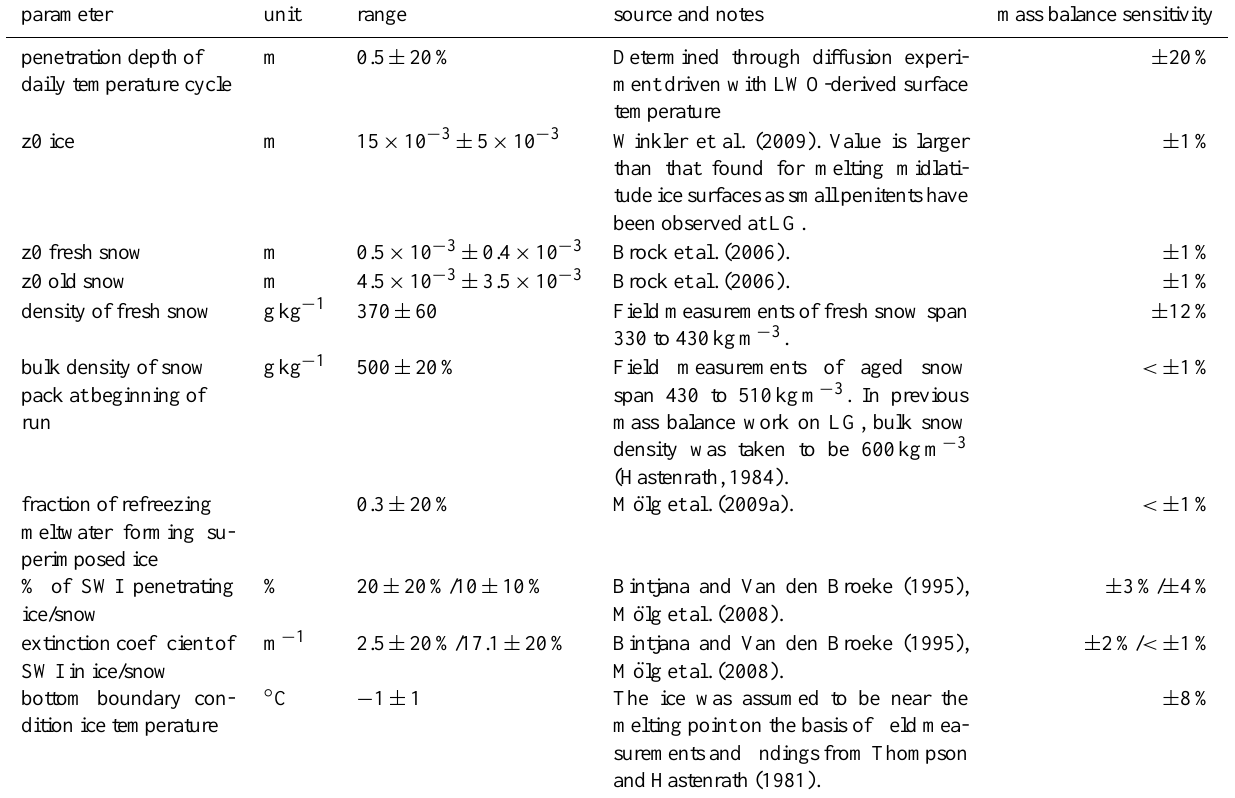
Table 3. Mass and energy balance model input parameters that were determined by Monte Carlo optimization, showing the permissible value range and source of constraining data, and the mass balance response to perturbing individual parameters to the maximum and minimum of their permissible